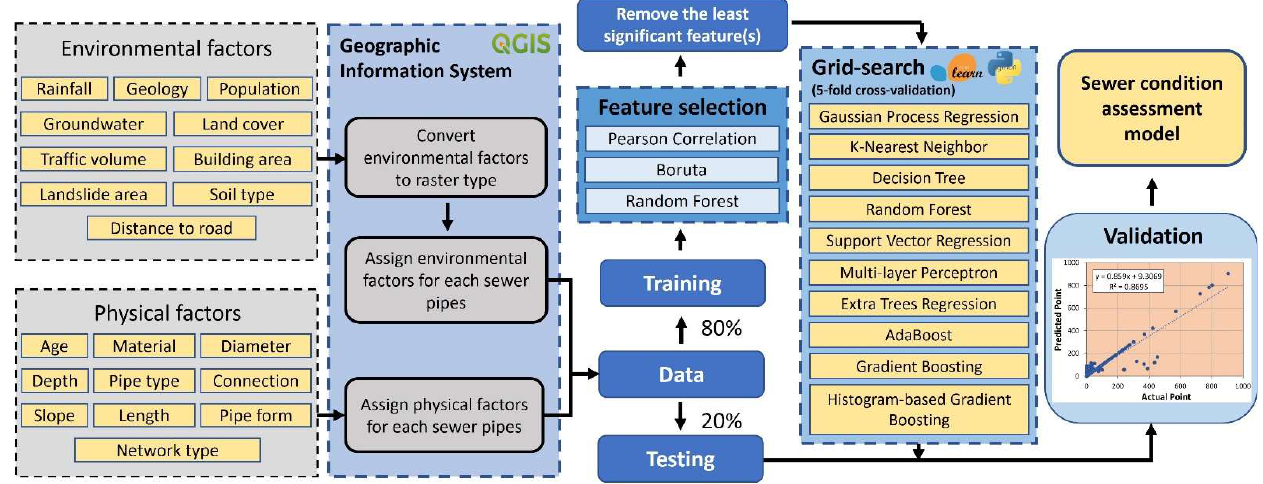
Figure 2. The flowchart for sewer condition assessment